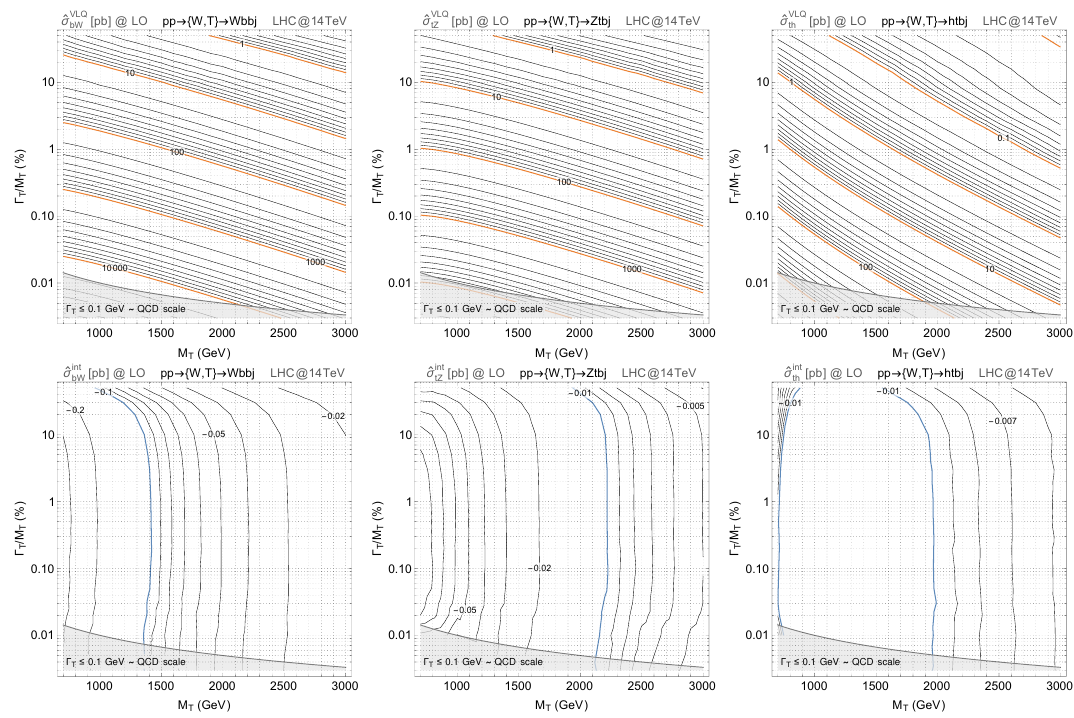
Figure 7 . Values of the ˆ σ VLQ (top row) and ˆ σ int (bottom row) bare cross sections, in pb, for the pp → Wbbj (left), Ztbj (centre) and Htbj (right) processes, for 14 TeV LHC proton-proton collisions. The bare cross sections are shown in ( M LHC proton-proton collisions are shown in figure 18, and the case of T production through Zt exchanges is treated in figures 26 and